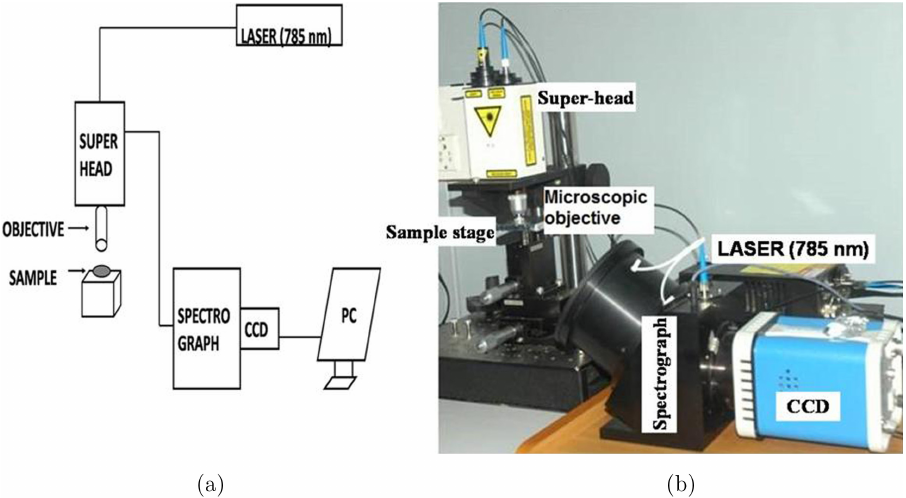
Fig. 2. Raman microprobe employed for acquiring spectrum from cell pellets. (a) Schematic Representation, (b) Photographic